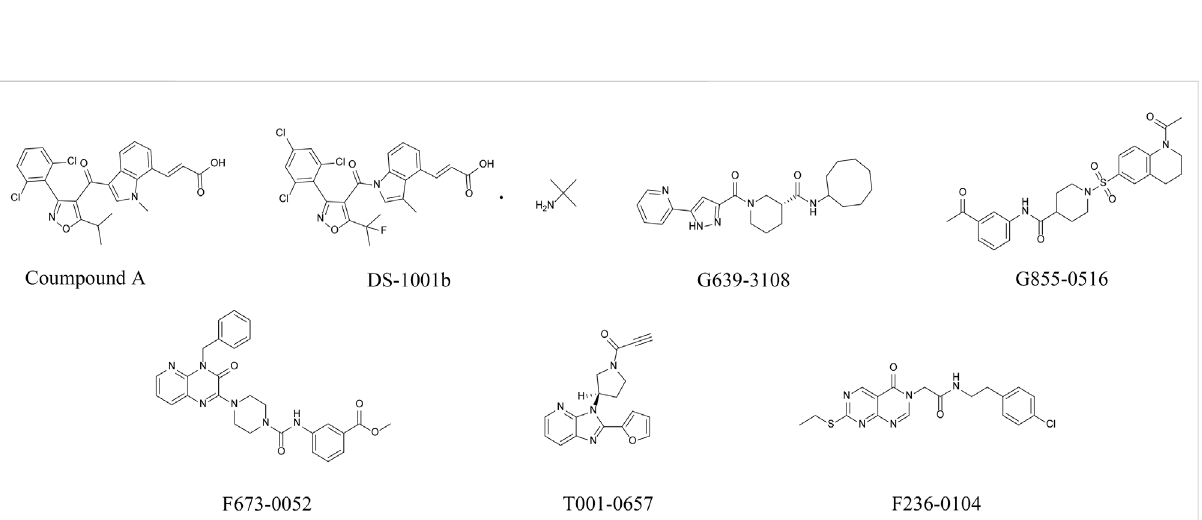
FIGURE 2 Chemical structures of the positive compound and fi ve candidate compounds after preliminary cellular evaluation. (Error bars are mean ± S.D. for three replicates).